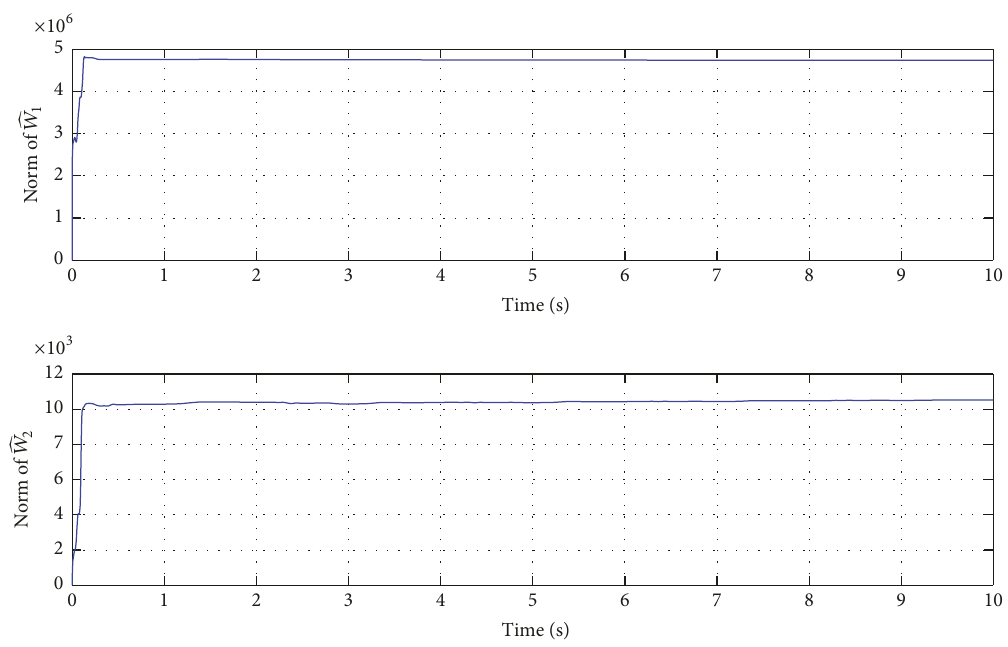
Figure 4: Evaluations of NN weights without